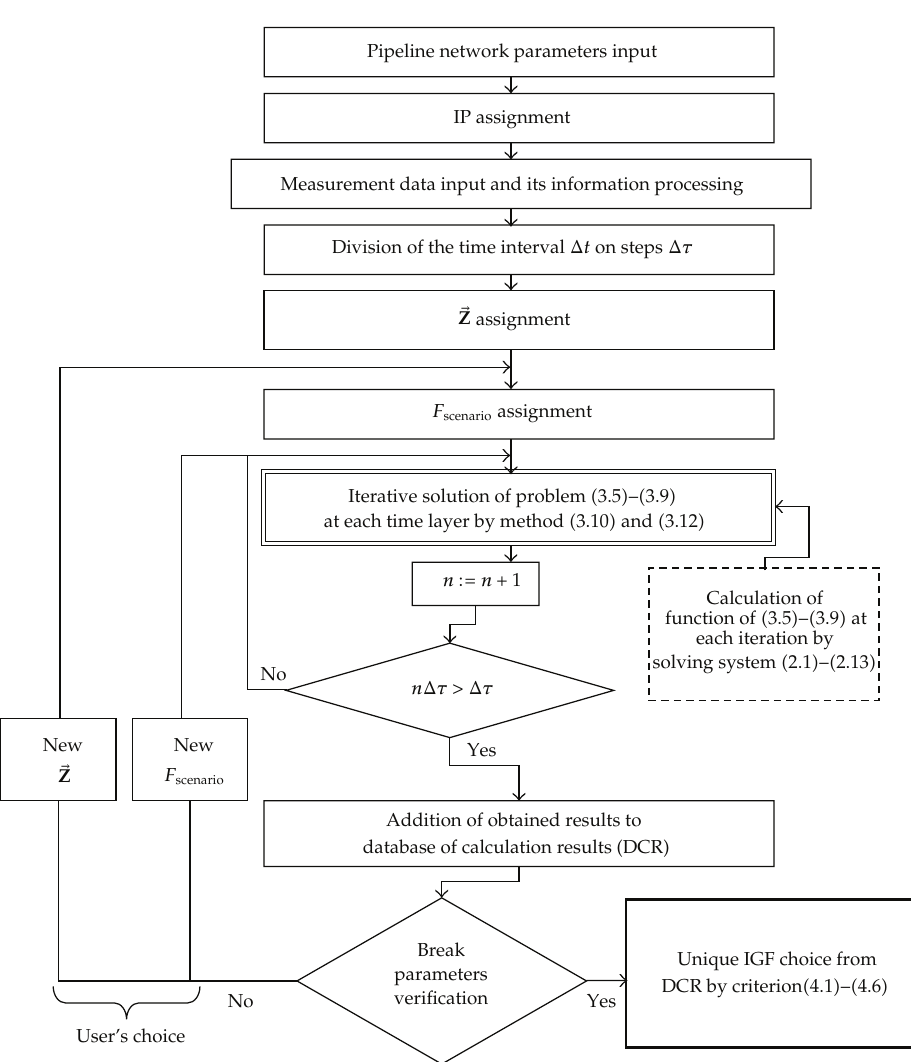
Figure 2: Flow diagram for the numerical implementation of the